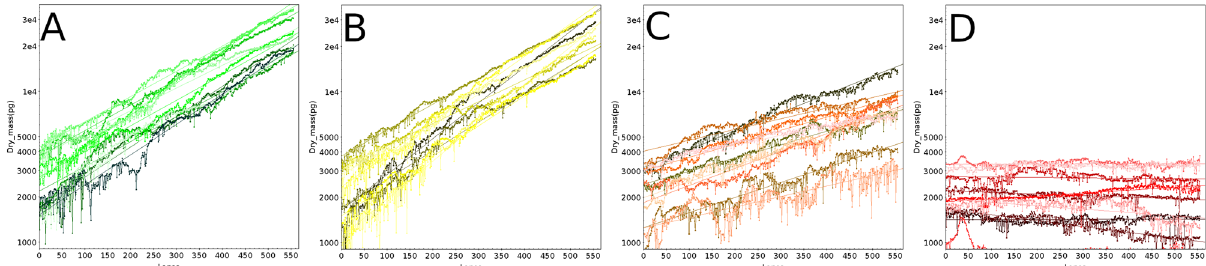
Figure 3. 92.5 h-live monitoring of HEK populations starting on day 1 after addition of increasing staurosporine (STS) concentrations. Each line on these plots corresponds to the monitoring of one field encompassing multiple cells together with its linear fit (same color), and each STS concentration is monitored on 9 fields. ( A ) 4 nM STS, ( B ) 20 nM STS, ( C ) 100 nM STS, ( D ) 500 nM